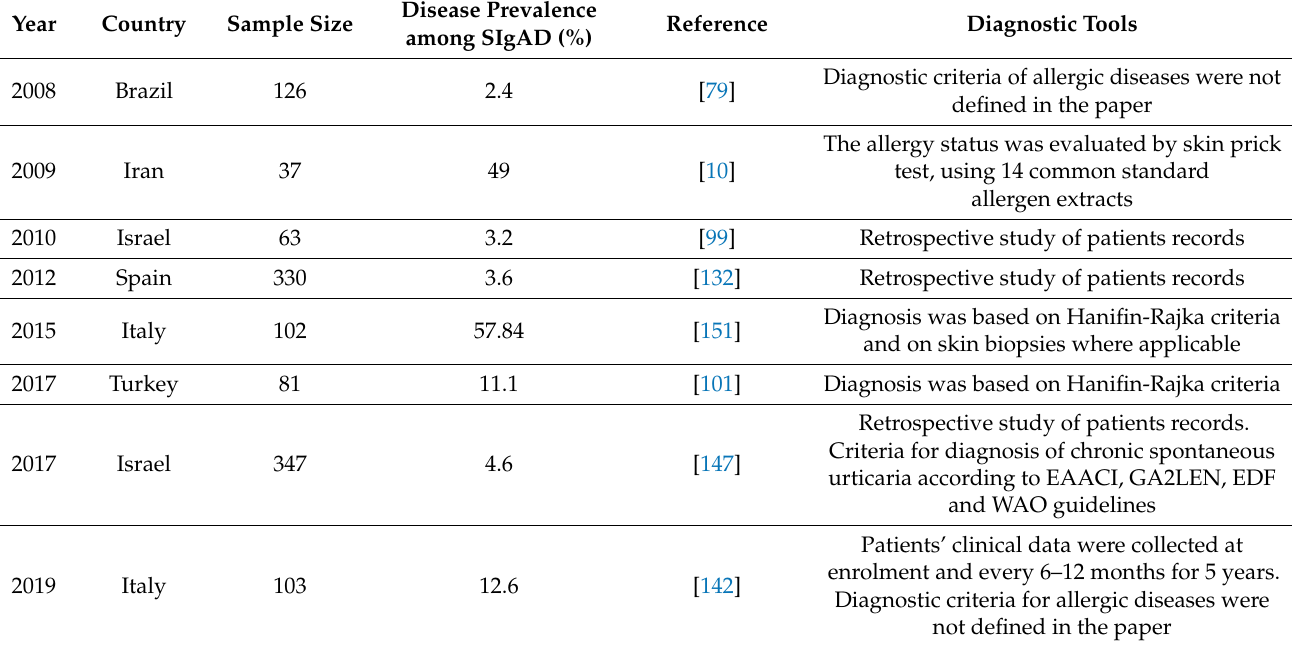
Table 3. Atopic dermatitis and sIgAD.